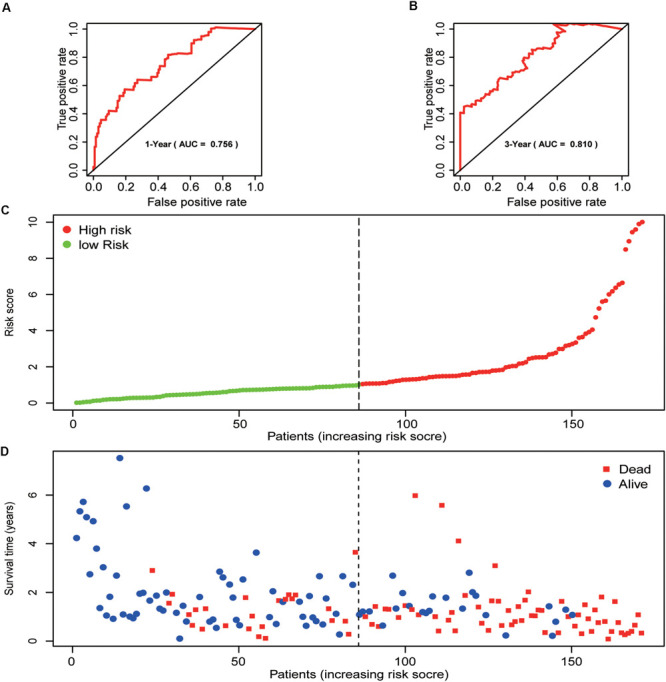
Prognostic analysis of the pancreatic cancer cohort. (A) 1-year ROC curve analysis of the prognostic model. (B) 3-year ROC curve analysis of the prognostic model. (C) Risk score distribution of patients in the prognostic model. (D) Survival status scatter plots for patients in the prognostic model.